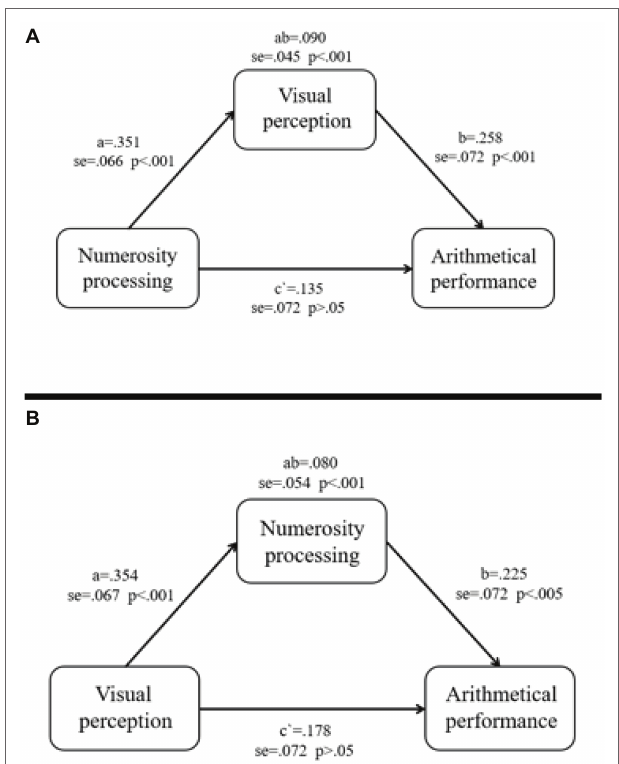
FIGURE 2 | Mediation analyses for the differential contributions of numerosity processing and visual perception to arithmetical performance. (A) The mediation effect of visual perception on the relation between numerosity processing and arithmetical performance. (B) The mediation effect of numerosity processing on the relation between visual perception and arithmetical performance. (1) Arithmetical performance refers to the non- standardized residual of arithmetic computation after controlling for general cognitive processing such as non-verbal matrix reasoning, mental rotation, and choice RT, as well as age and gender differences. (2) The model is constrained by the assumption of c = ab + c `. c , direct effect of the original predictor; ab , indirect effect of the mediator; and c `, the remaining, unmediated direct